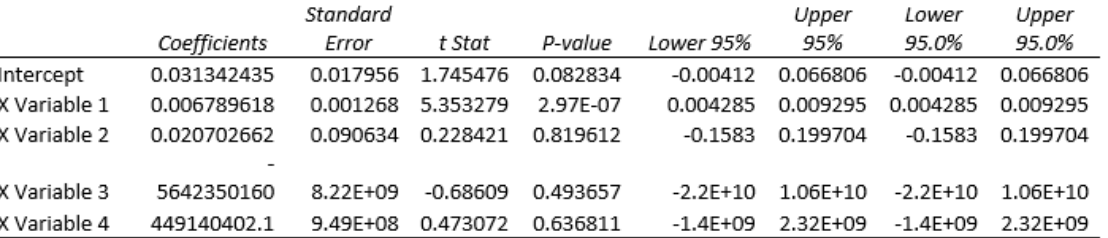
Figure 7. Chlorophyll prediction from river flow, AOD, wet and dry deposition.